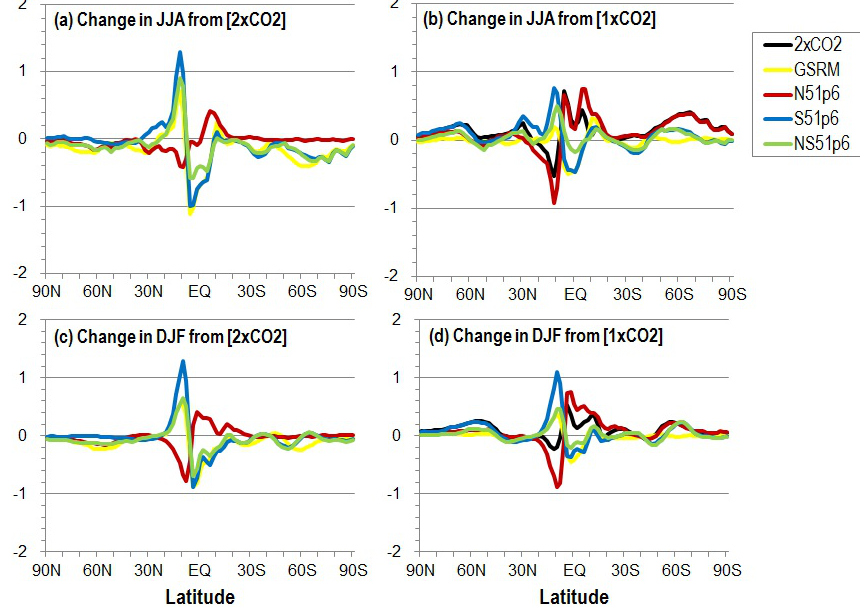
Fig. 7. Latitudinal distribution of the differences in precipitation (in mmday − 1 ) for June-July-August (JJA – top panels) and December- January-February (DJF – bottom panels) that would result after imposing both a CO 2 doubling and solar reductions of either 1.8% globally or 6% reductions in solar radiation from 51 ◦ latitude to the pole in the Northern, Southern, or both Hemispheres. The left column shows the effect of the solar reductions from the 2 × CO 2 simulation and the right column from the 1 × CO 2